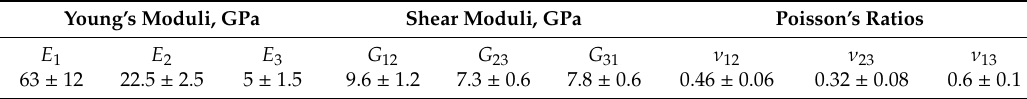
Table 1. The engineering elastic constants of CFRP panel 1 . Young’s Moduli,